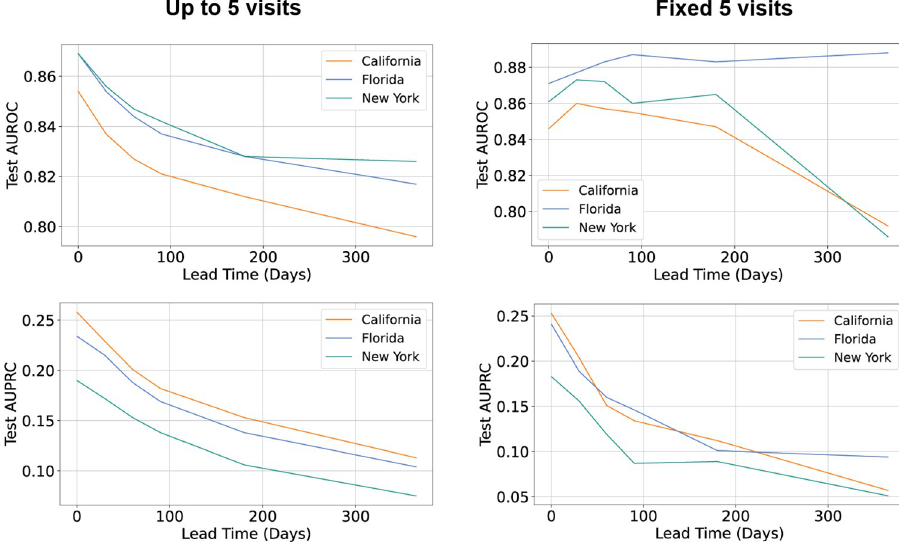
Fig 3. Effect of lead time on malnutrition prediction. Prediction performance of the best-performing model declines with longer intervals between prediction and diagnosis (left). Holding trajectory length constant, the detrimental effect of lead time is attenuated for AUROC but not for AUPRC